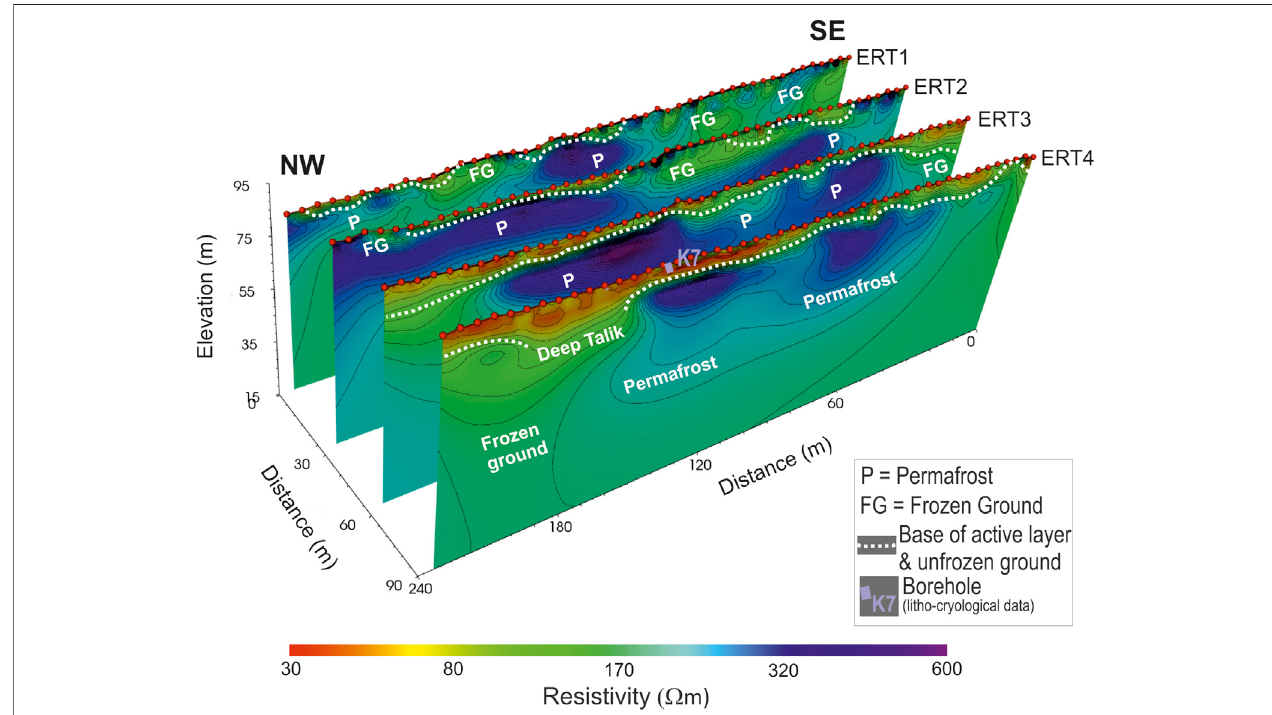
FIGURE 8 | 3D representation of the ERT sections in Site 1A. According to the CRIM analysis and to the resistivity-cryological patterns, the interpretation of the active layer and unfrozen ground bottom (white dashed line) is marked by a resistivity value of 100 Ω m. This interpretation, together with the topographic surface (highlightedbyreddotsrepresentingelectrodesdeployedduringtheacquisition),wasusedtobuildtheALTandUGTmapshownin Figure9 .Thetalik,permafrost,and frozen and unfrozen ground areas are also highlighted.